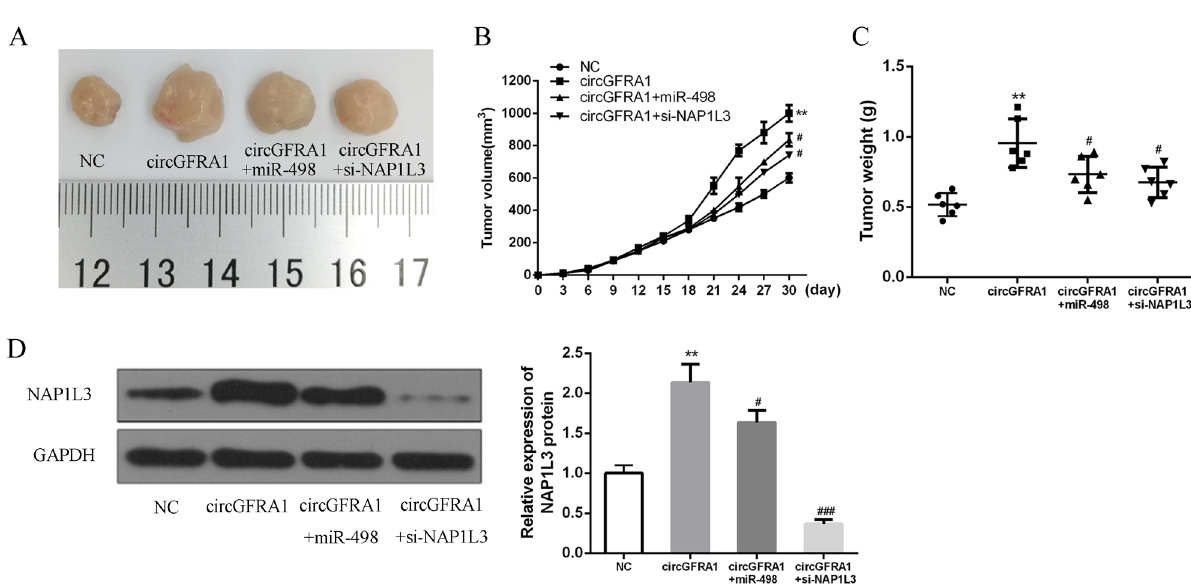
Figure 6. CircGFRA1 enhanced HCC progression in vivo by regulating the miR-498/NAP1L3 axis. ( A ) Subcutaneous tumor from 4 groups. ( B ) Tumor volumes of nude mice. ( C ) Tumor weight on mice at the 30th day. ( D ) The expression of NAP1L3 of NAP1L3 and GAPDH in cells transfected with NC, circGFRA1, circGFRA1 + miR-498, and circGFRA1 + si-NAP1L3 via using western blotting. ( # P < 0.05 ### P < 0.01 vs circGFRA1, **P < 0.01 and ***P < 0.001 vs